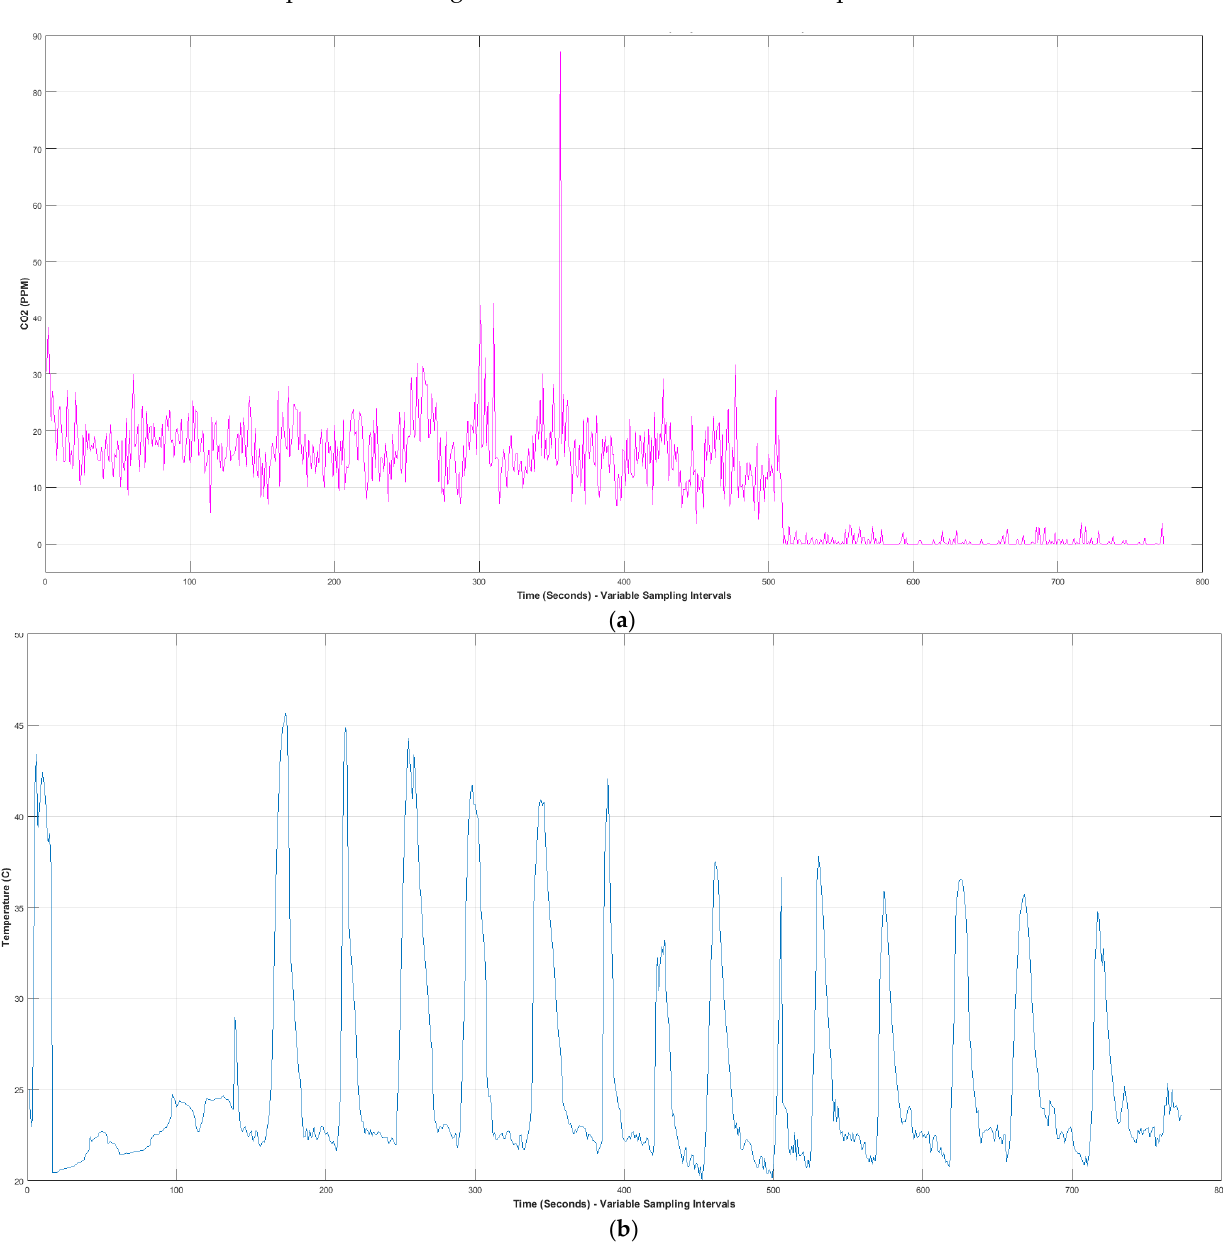
Figure 6. The Bi-cluster formation from QU-H10 and QU-C05 data-captured was during 8 h from CO2 and Temperature Variables: ( a ) The double-interpolated CO2 from QU-H10 and QU-C05 data-captured during 8 h in ppm and ( b ) The double-interpolated Temperature from QU-H10 and QU-C05 data-captured during 8 h in °C.